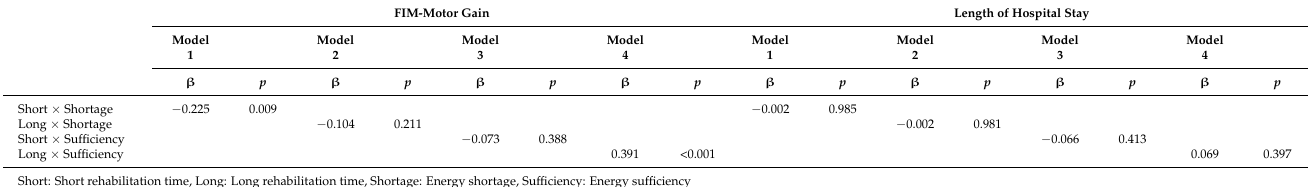
Table 3. Multivariate regression analysis for FIM-motor gain and length of hospital stay.